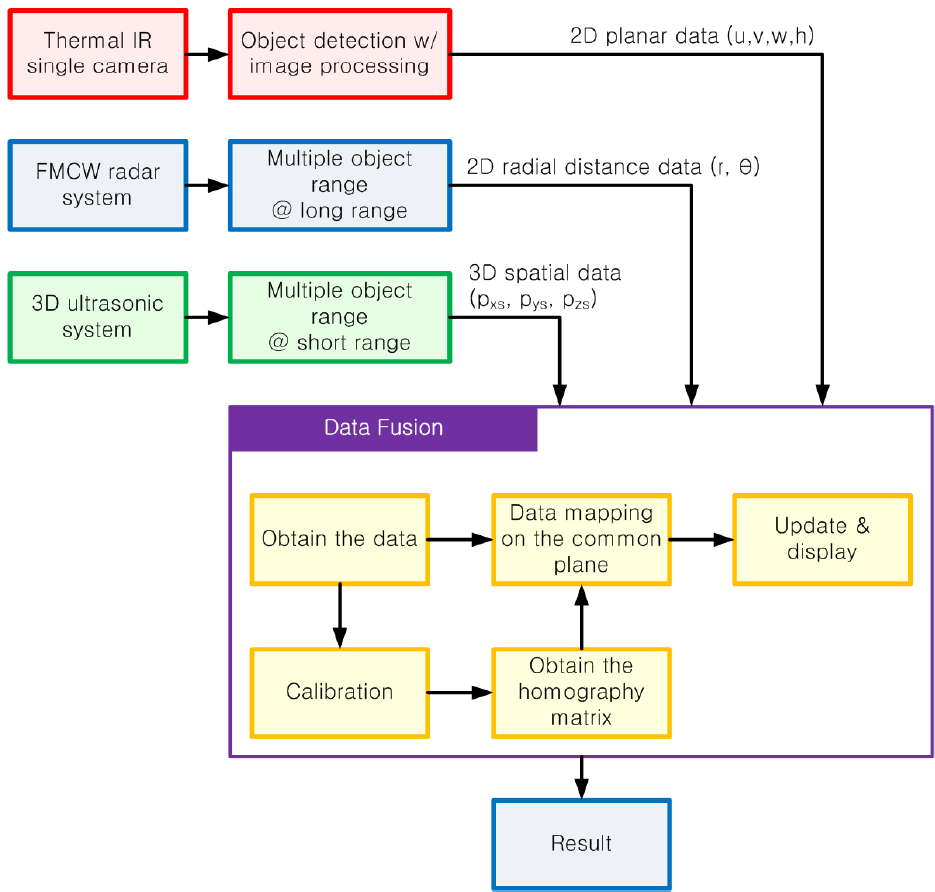
Figure 9. Overall block diagram of the proposed sensor fusion. Table 2. The specification of the chosen